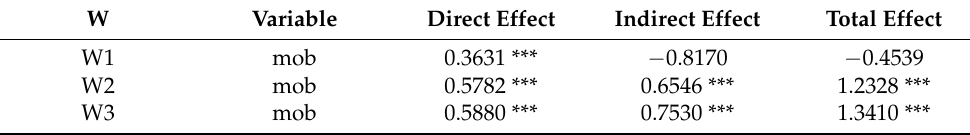
Table 6. Spillover effect of decomposition